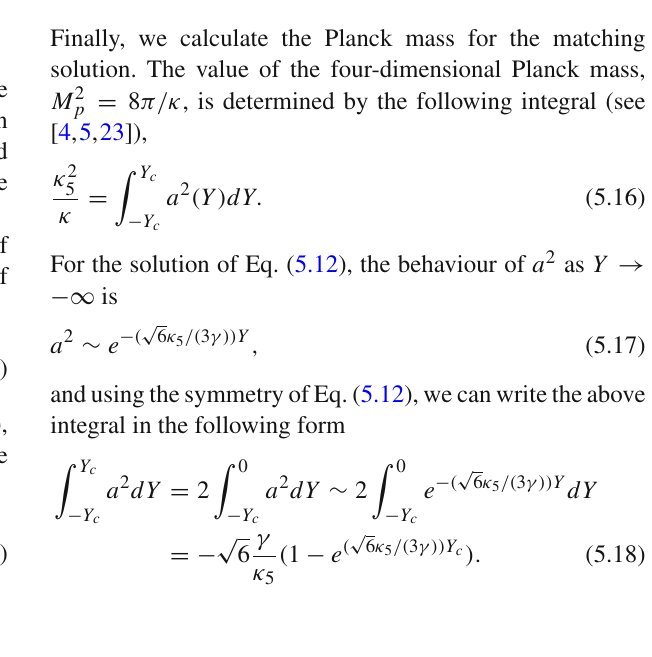
Fig. 2 Graph of h − ( a )